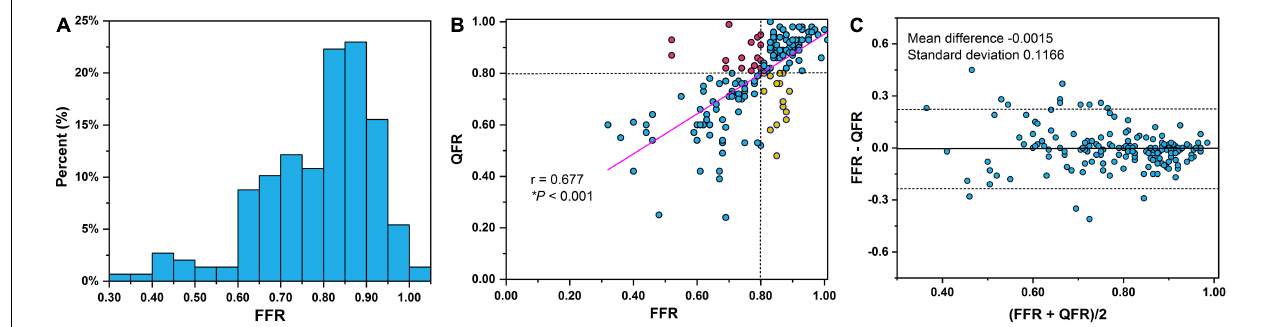
FIGURE 3 | (A) Distribution of FFR measurements. Notably, 12.6% ( n = 22) of the lesions were in the FFR 0.75–0.80 interval. Correlations (B) and agreement (C) between QFR and FFR. Dashed lines in Bland–Altman plot illustrate the mean difference ± 1.96 standard deviation. QFR, quantitative flow ratio; FFR, fractional flow reserve.